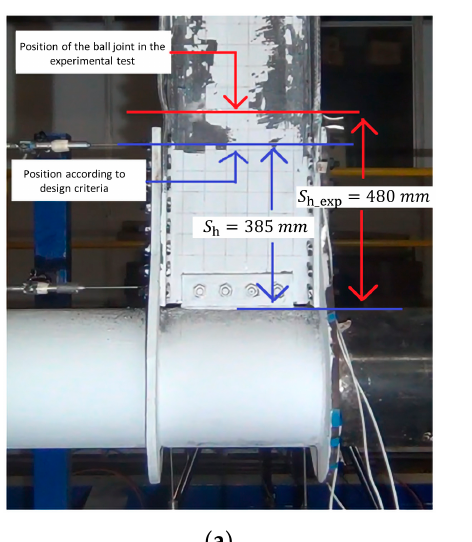
Figure 8. ( a ) Comparison of plastic hinge location according to design and experimental results; and ( b ) trial side view showing the torsional lateral buckling effect.